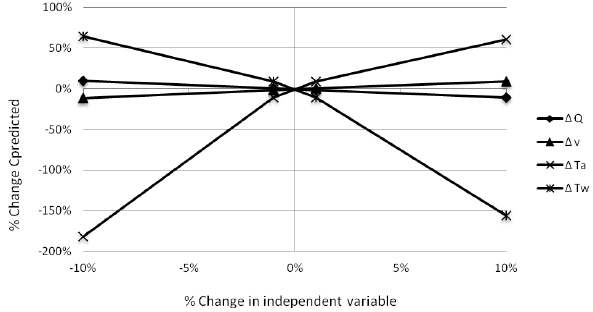
Fig. 7. Model sensitivity of phosphorus concentration to changes in input parameters ( Q – flow, υ – velocity of water in the stream, T a – temperature of air, T w – temperature of water).